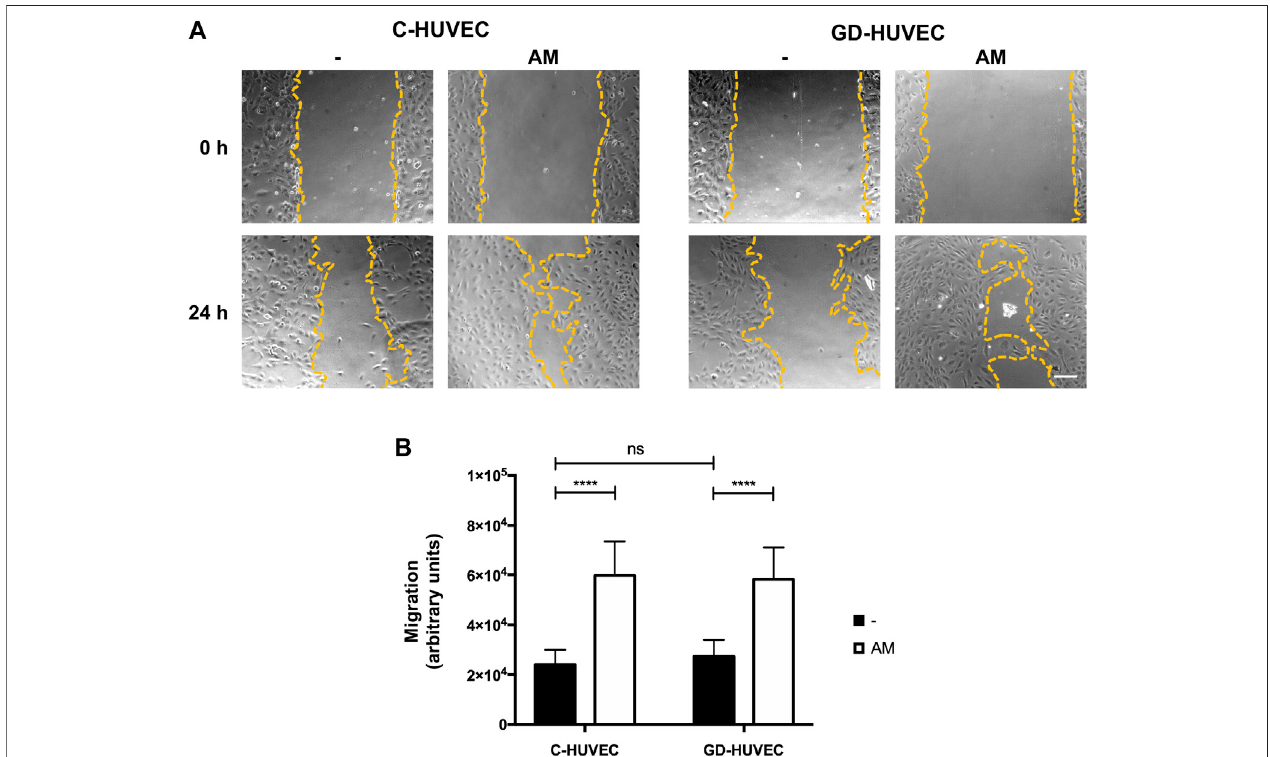
FIGURE6| AMinducescellmigrationinC-andGD-HUVECs. (A) HUVECswerewoundedandallowedtomigratefortheindicatedtimeinthepresenceorabsence of AM. Representative scratch assay from each experimental condition are shown. The wound edges are outlined in yellow. (B) Quanti fi cation of the difference of migration between 0 and 24 h. ANOVA and Tukey ’ s multiple comparison test: **** p < 0.0001.